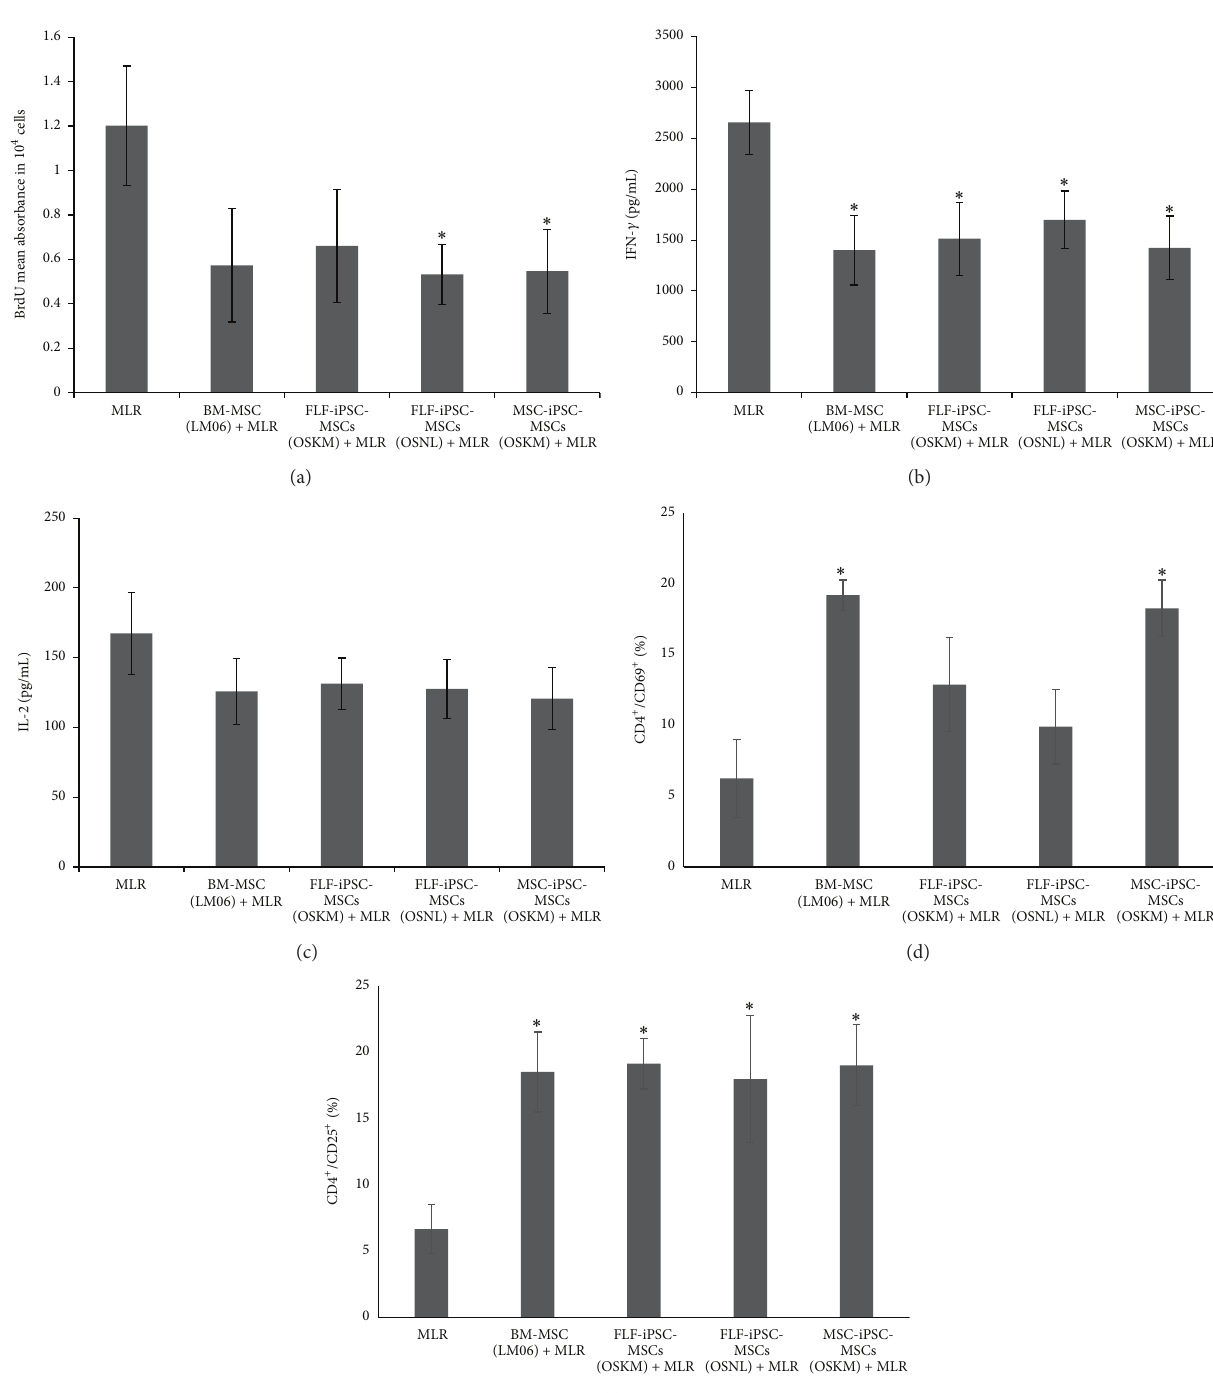
Figure 6: Status of activated CD4 + T cells in thepresence of hiPSC-MSCs.(a) IFN- 𝛾 were determined at 48 hours by ELISA. The values are the means ± SD from 3 independent experiments, (b) concentrations of IL-2, and (c) proliferation in MLR/MSC cocultures. MLR cultures were set up in presence or absence of hiPSC-MSCs. BrdU incorporation was significantly lower in MSC-ips-MSCs and FLFiPSC-MSCs (OSNL) in comparison to absence of MSCs. (d) Expression of the T-cell activation markers CD69 and (e) CD25 on CD4 + 5 days after stimulation in a 12-well dish in the presence or absence of hiPSC-MSCs. ∗ : significance difference with MLR 𝑝 ≤ 0.05